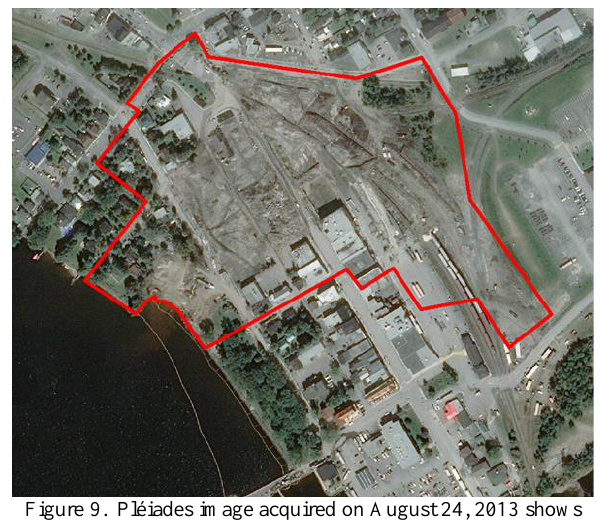
Figure 9. Pléiades image acquired on August 24, 2013 shows the progress of the reclamation effort.